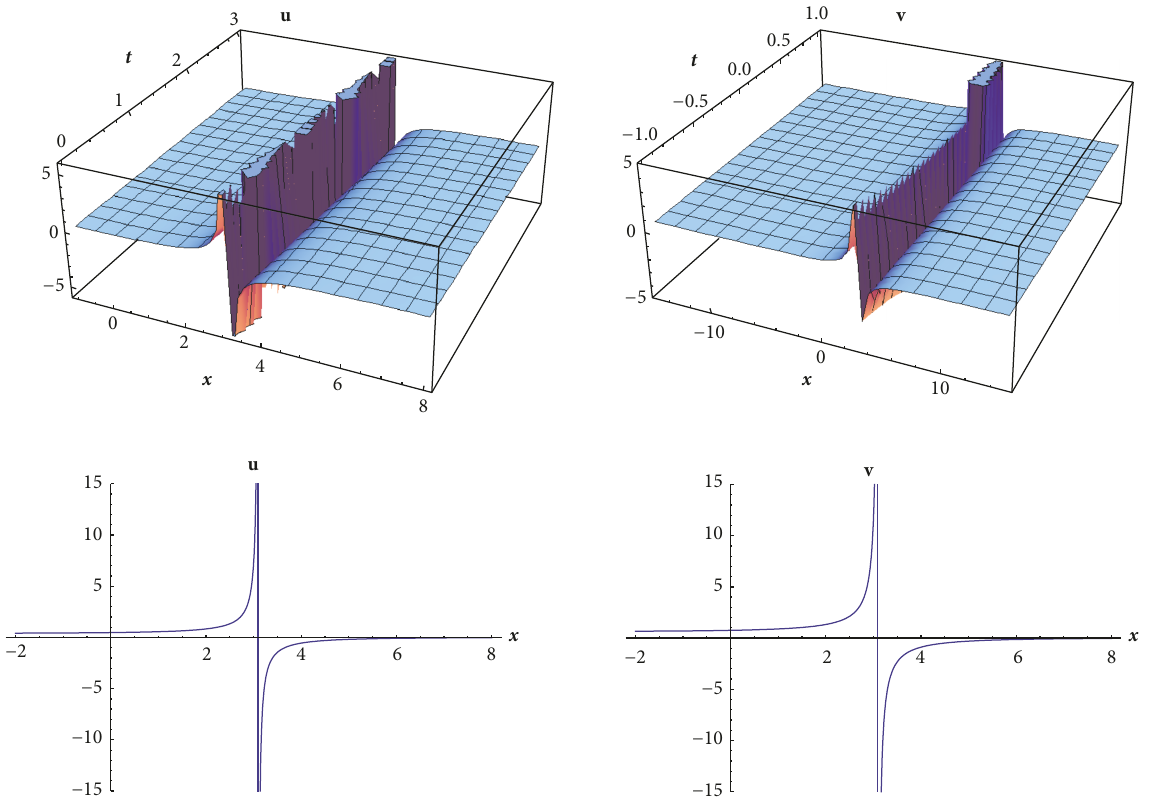
Figure 2: The 3D and 2D surfaces of the solution (23) by considering the values 𝑏 1 = 0.5 , 𝑎 1 = 0.2 , 𝑘 = 1.6 , 𝑐 = 0.2 , 𝑑 = 0.01 , 𝜎 = 0.3 , 𝜖 = 0.9 , 𝑦 = 1.5 , and 𝑡 = 0.007 for 2𝐷 .